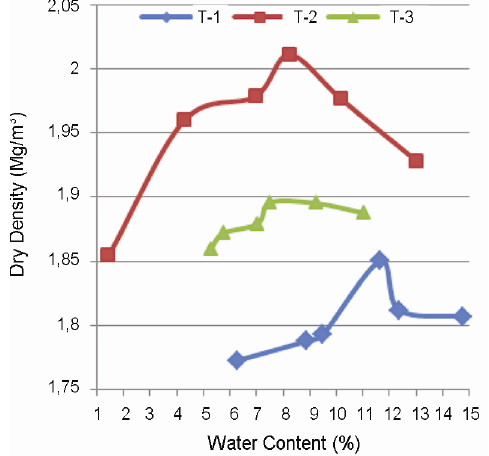
Fig. 7. Dry density versus water